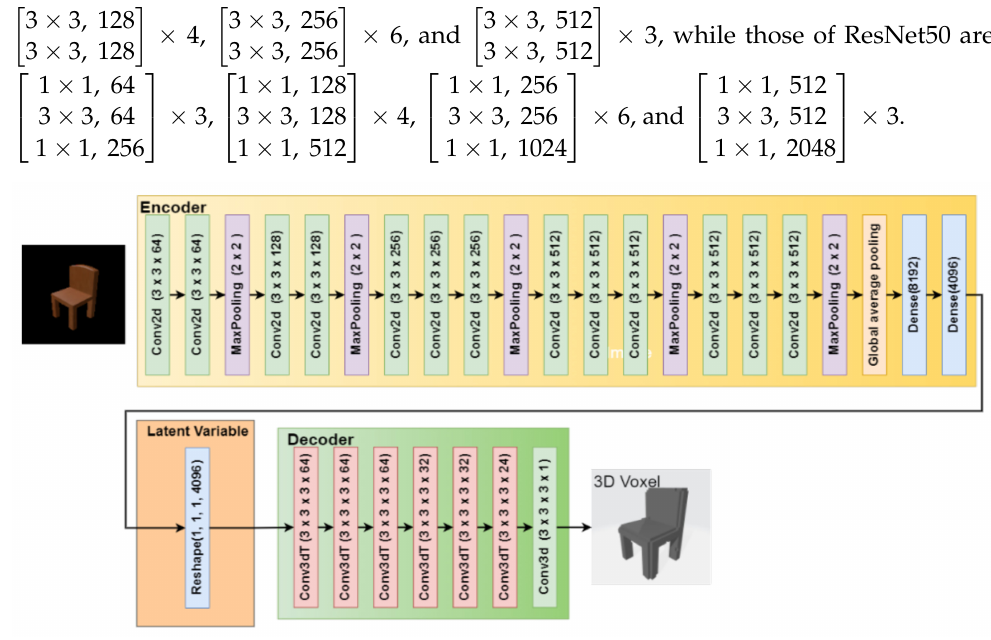
Figure 2. Structure of VoxGen with the modified-VGG16 encoder.